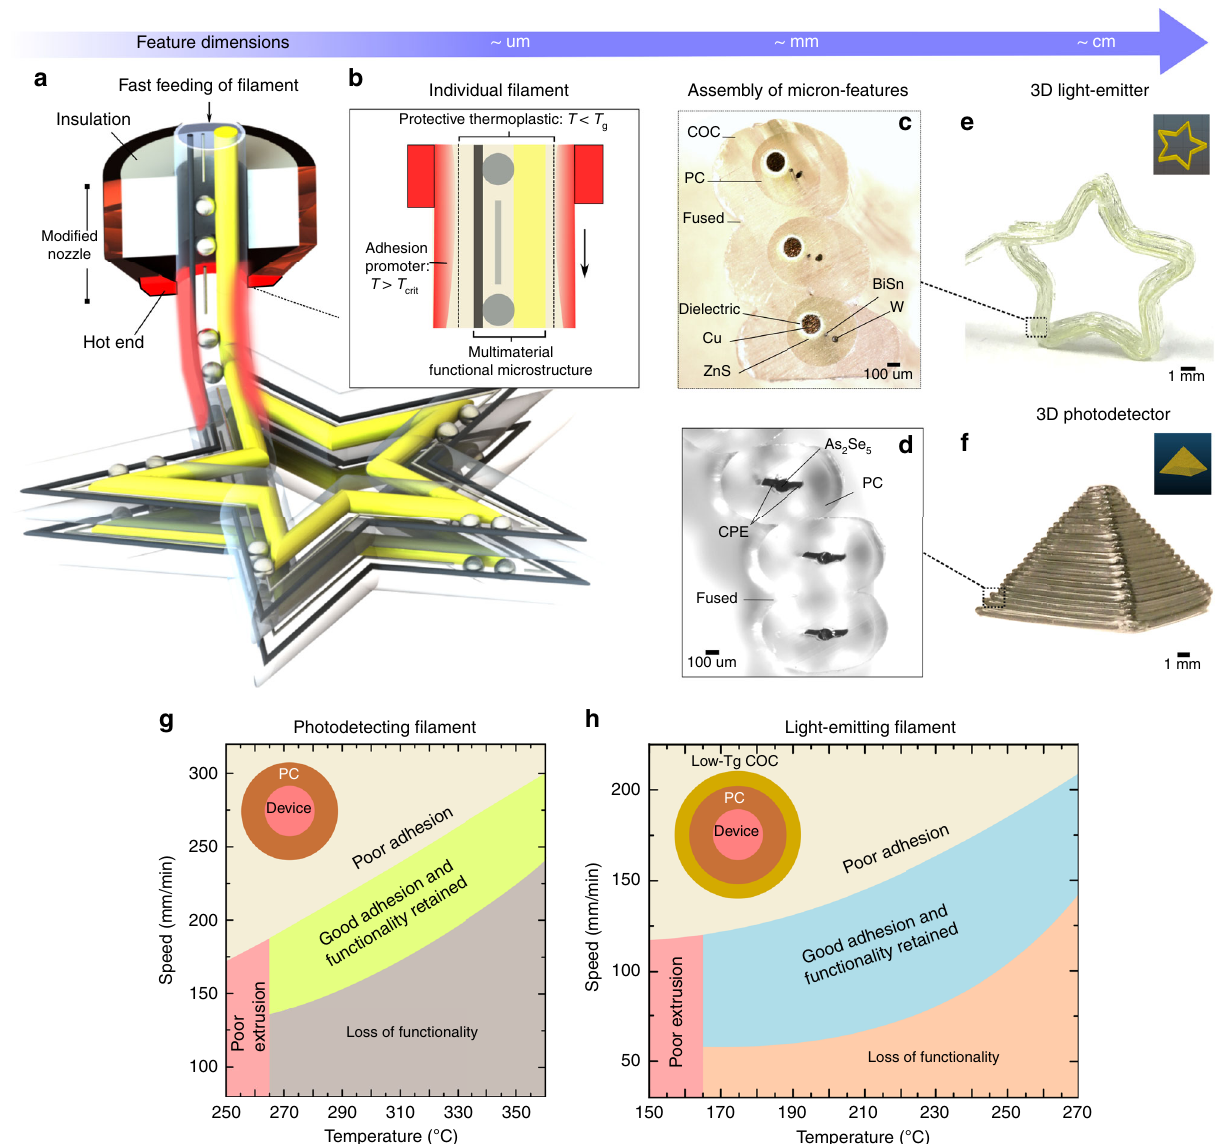
Fig. 3 Multiscale Print Process. a The microstructured multimaterial fi lament is fed quickly through a short hot end. Precision of the print can be enhanced by using hot end and fi laments of smaller diameters. b Filament surface heating (FSH) generates a surface-heated effect with the fi lament surface temperature rising beyond its critical fusing temperature (T crit ) while maintaining the temperature of the inner encapsulating polymer at a temperature below its glass transition (T g ). Microscale features within the ink can be precisely arranged for varying functionalities. c , d Cross-sectional optical micrographs showcasing a hierarchical assembly of millimeter-scale fused lines containing interfacial microstructures of different material classes. These assembly can be further stacked and shaped into three-dimensional centimeter-scale objects like e a star and a f pyramid which are printed from the light- emitting and light-detecting fi laments, respectively, via FSH. Speed-temperature plots for the printing of g PC-cladded light-detecting and h